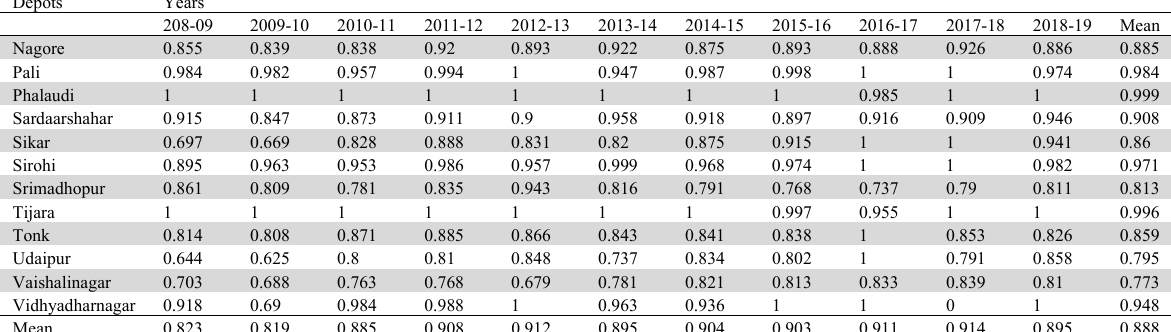
Efficiency Values of NSM-VRS (Continued) Depots